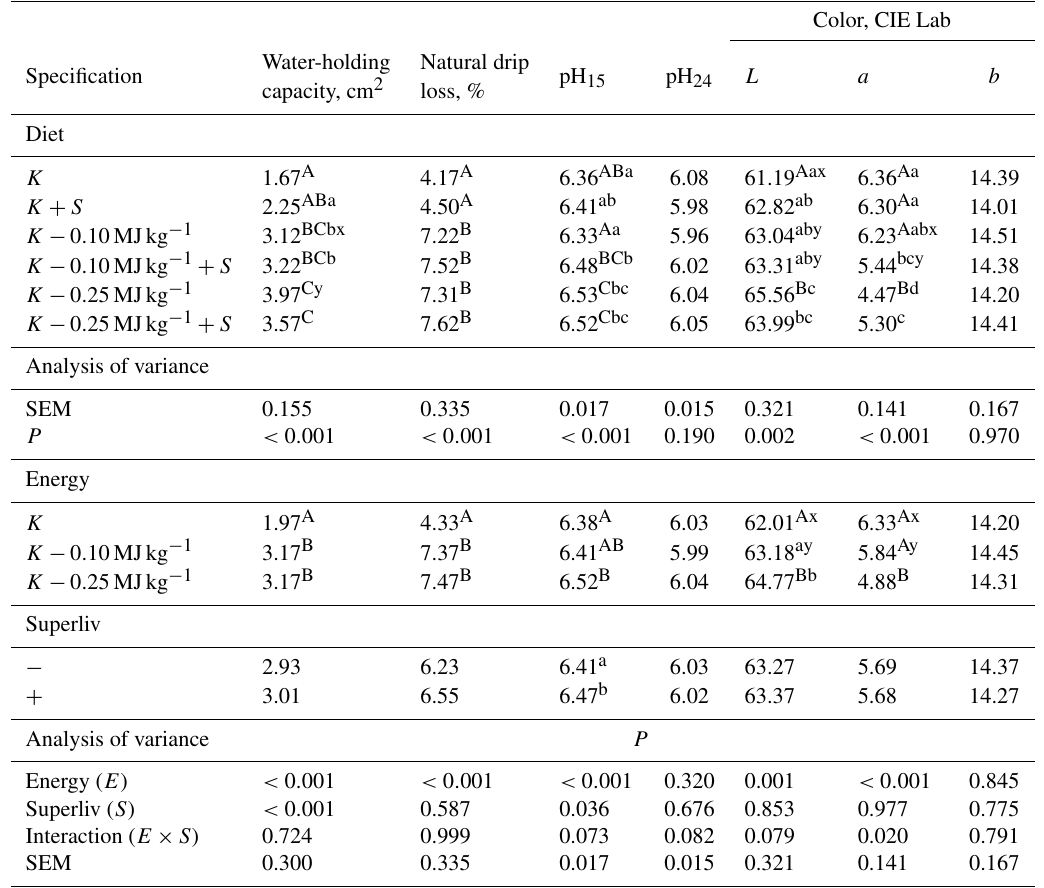
Table 6. Meat quality